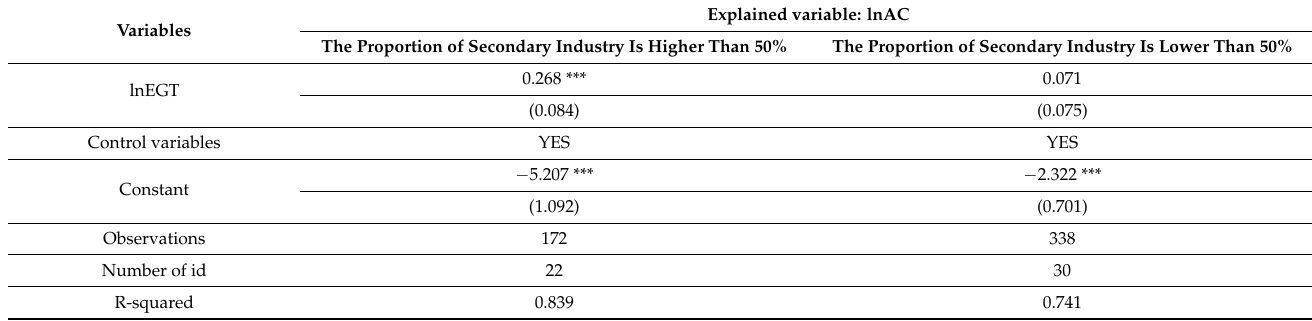
Table 6. Industry heterogeneity regression